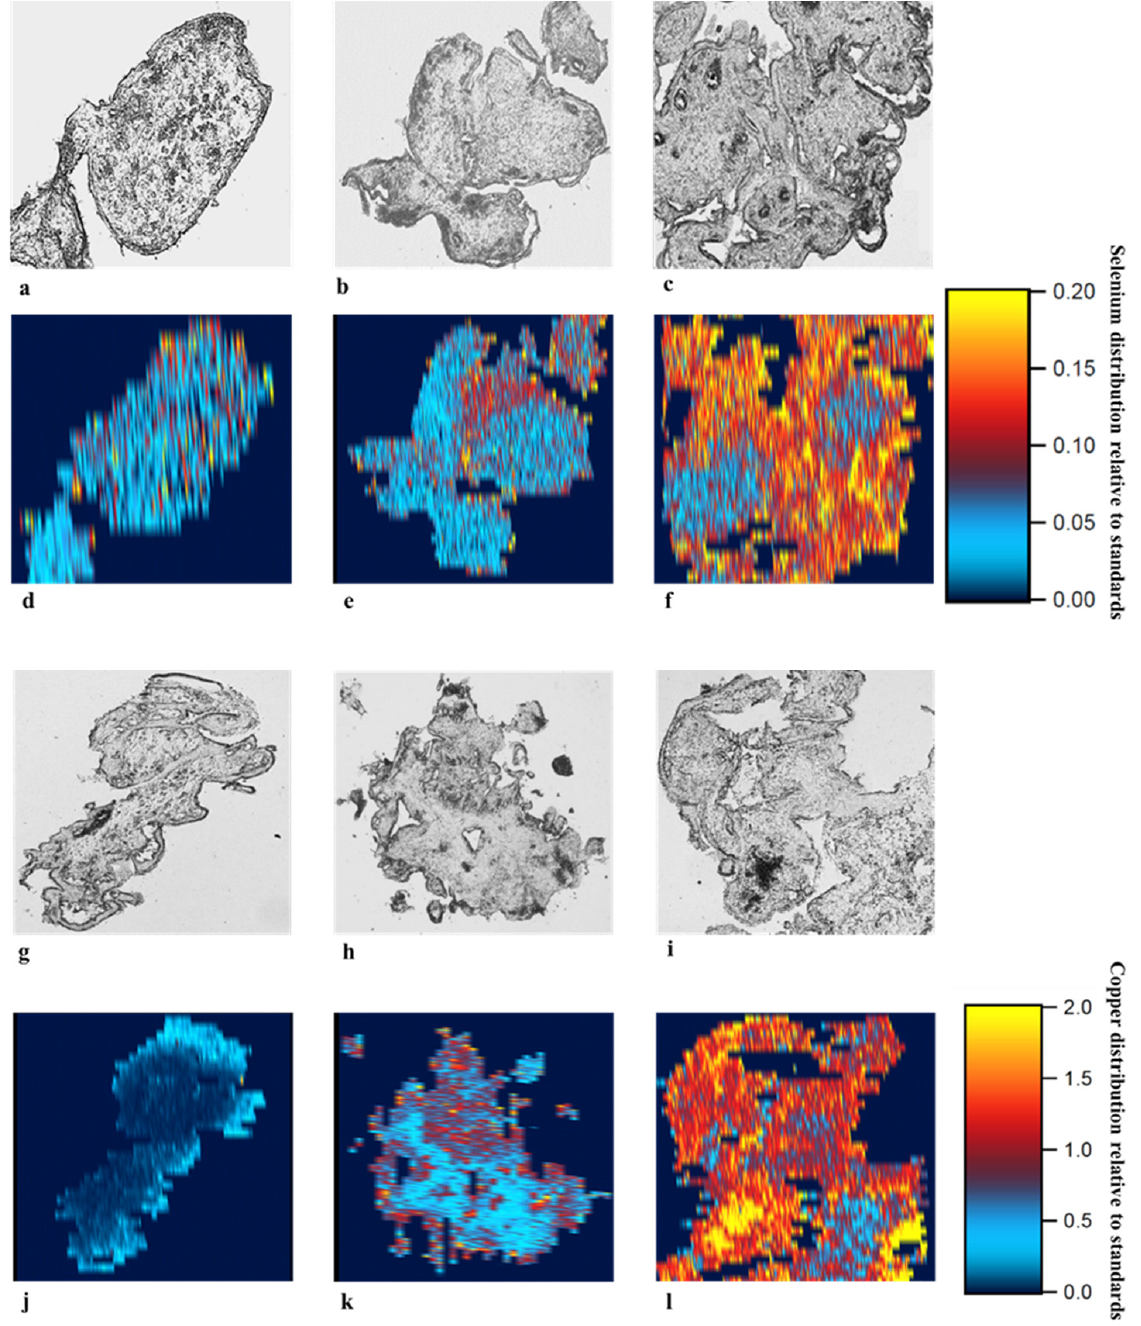
Figure 1. Selenium and copper uptake in first trimester human placental explants. Placenta explants (7–12 weeks of gestation) were supplemented with sodium selenite ( a and d : sterile MilliQ water, b and e : 0.8 µ M or c and f : 1.6 µ M) or copper (II) sulfate ( g and j : sterile MilliQ water, h and k : 20 µ M or i and l : 40 µ M) for 72 h ( n = 3). Tissue sections (10 µ m) were placed on microscope slides. Standards were made by dissolving 10% gelatine in 0, 1, 10, and 100 mM solutions of selenium and copper. Laser ablation inductively coupled plasma-mass spectrometry (LA-ICP-MS) analyses on the standard gelatine and placental explant sections were analysed using a Resolution 193 nm excimer laser ablation system coupled to an Agilent 7900x ICP-MS. Samples were ablated with a series of parallel lines: 23 µ m spots size, 23 µ m/s speed, 10 Hz repetition rate and a fluence of ~1 J/cm 2 . Intensity of micronutrients were recorded as counts per second for each isotope. Data was processed using the iolite data processing software, and element intensity calculated relative to the gelatine standards to form a 2D map of micronutrient distribution over a chosen surface of each placental explant